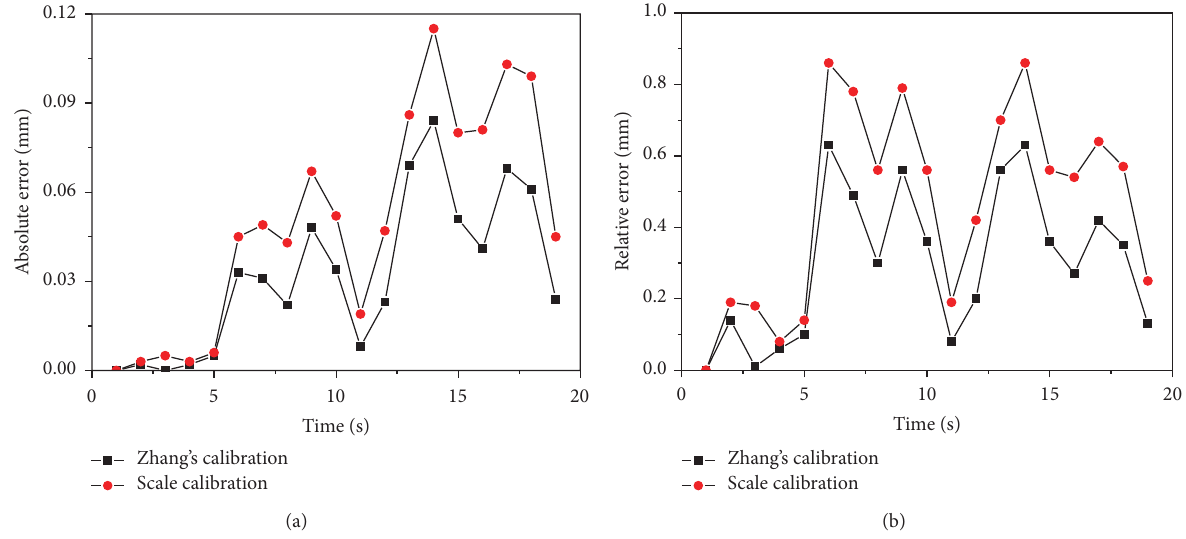
Figure 6: Error analysis of two calibration algorithms: (a) absolute error curve and (b) relative error curve.